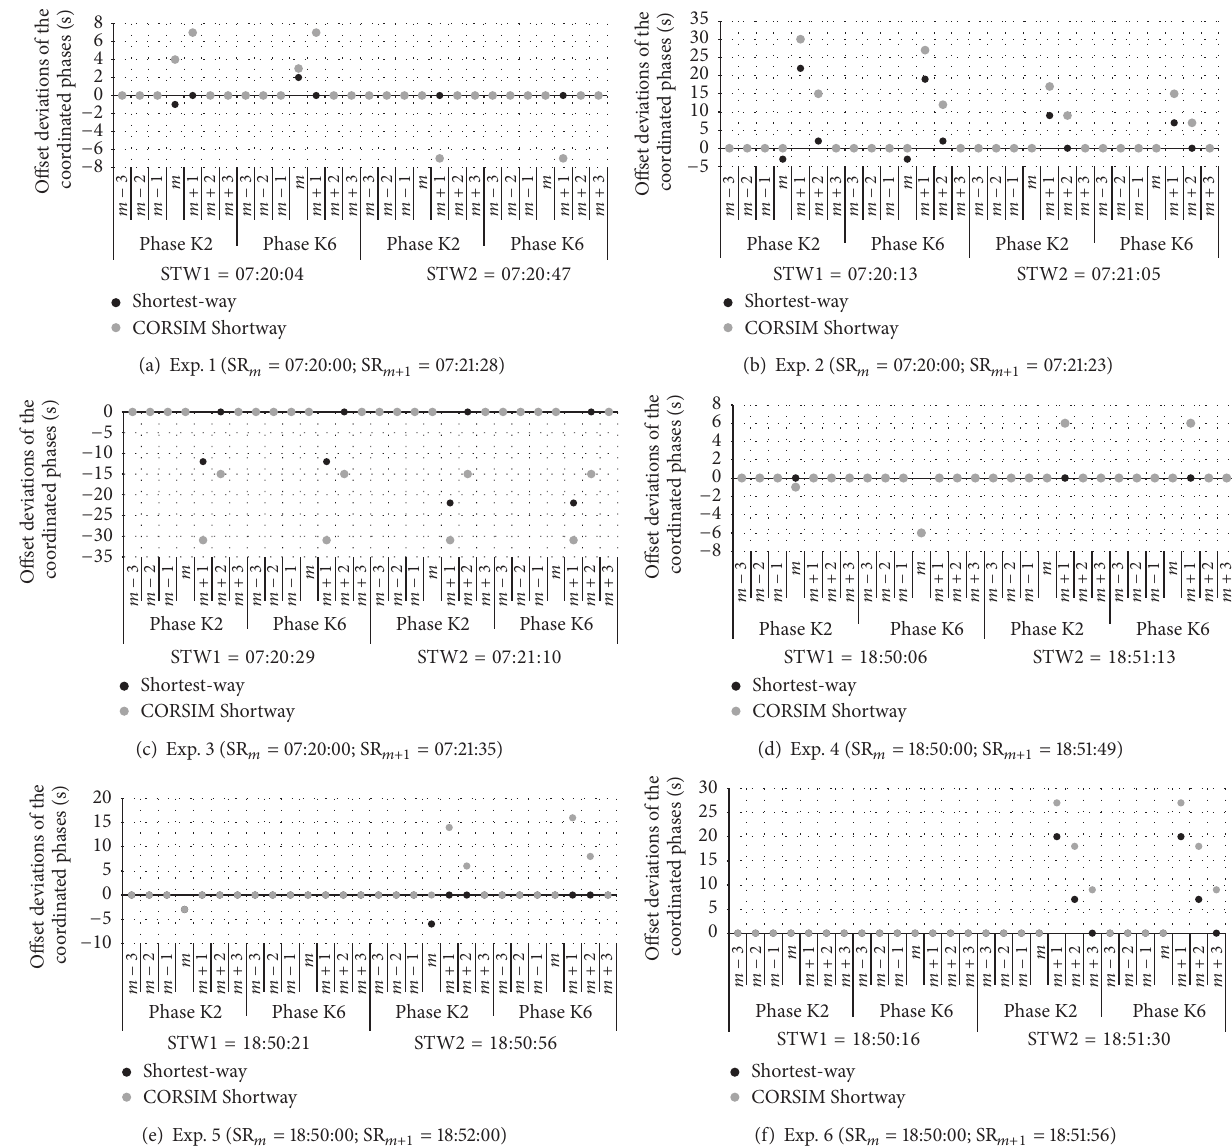
Figure 7: Offset deviations of the coordinated